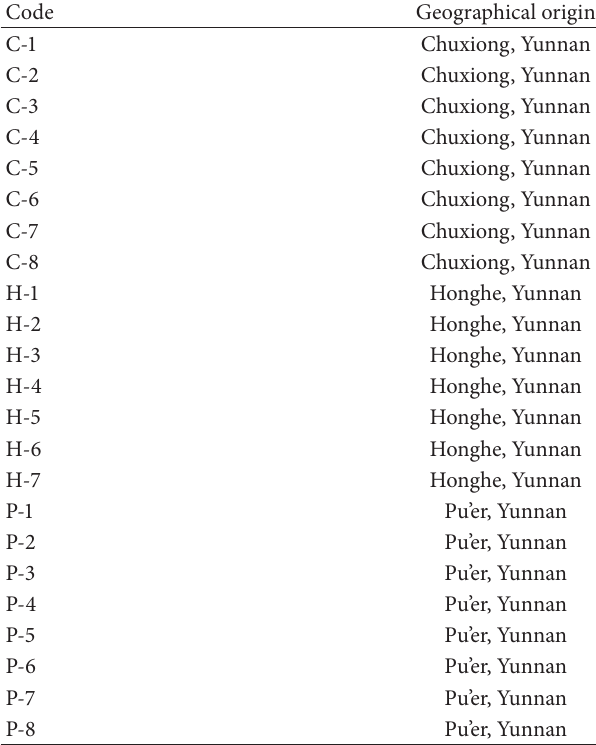
Table 1: Information of all the wild Wolfiporia extensa (Peck) Ginns